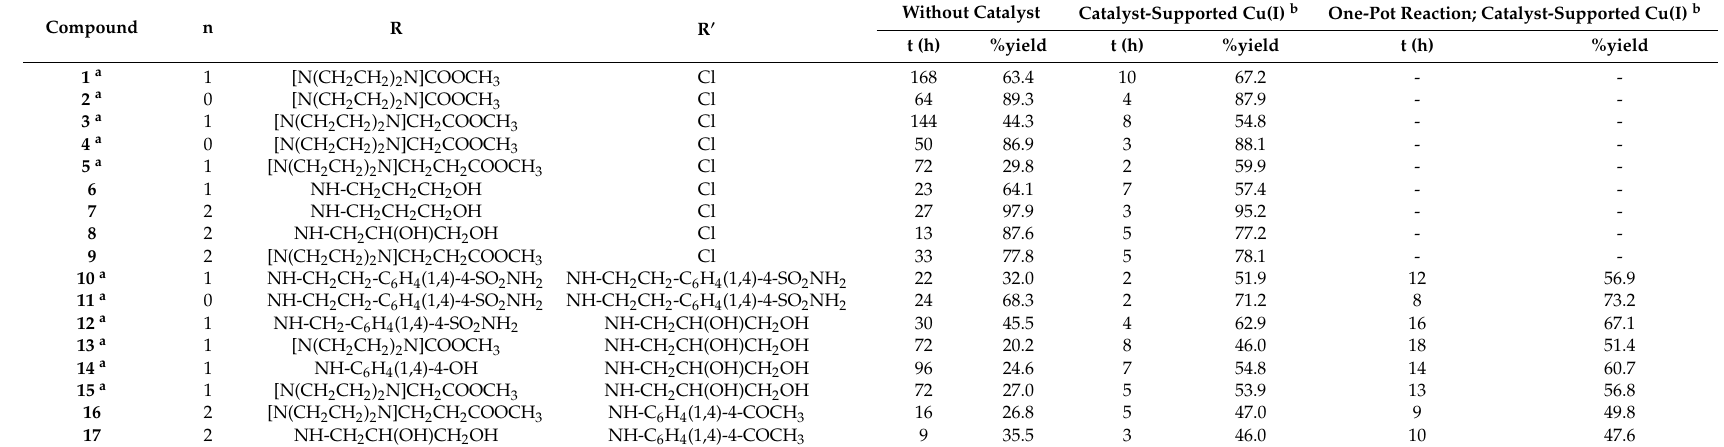
Table 1. Results of uncatalyzed and catalyzed syntheses of di- and trisubstituted 1,3,5-triazine derivatives including one-pot synthesis of trisubstituted 1,3,5-triazine